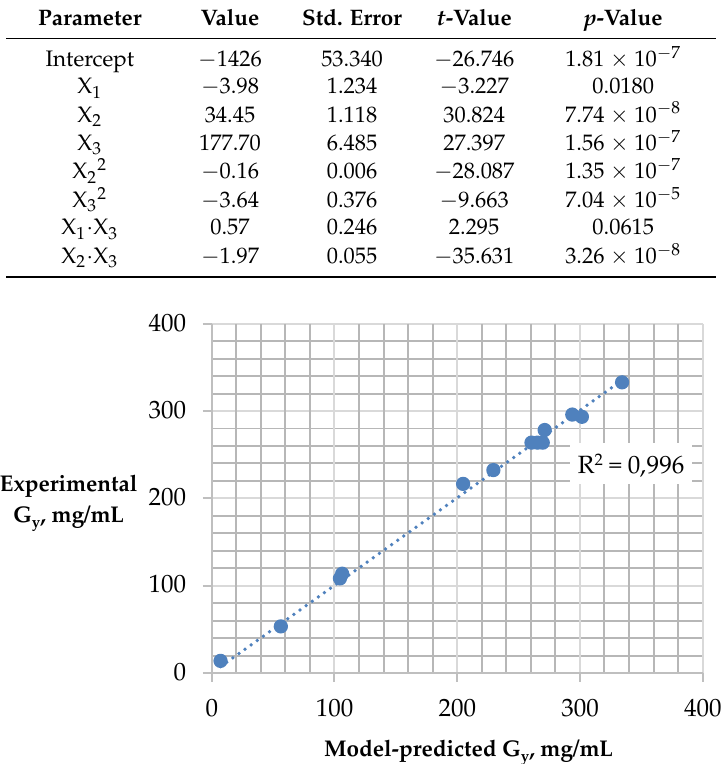
Figure 2. Analysis of variance for the theoretical (model-predicted) and experimental glucose yield for alkaline pre-treatment and acid hydrolysis.